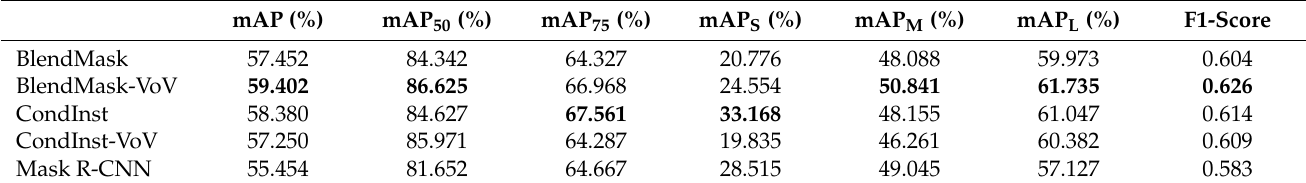
Table 5. Quantitative Evaluation of the test set in the segmentation detection